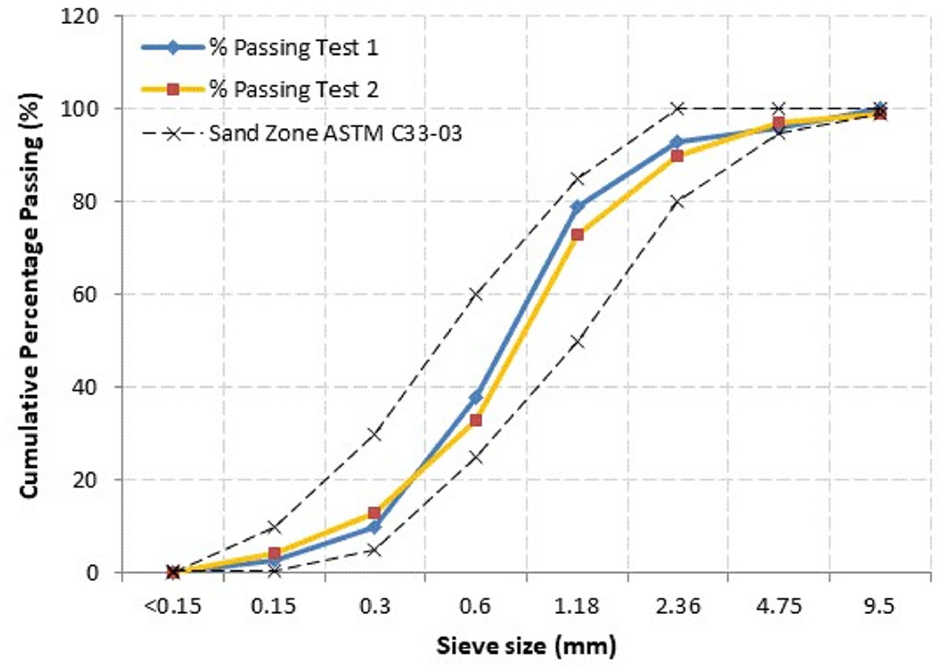
Figure 1. Fine sand grading curve.